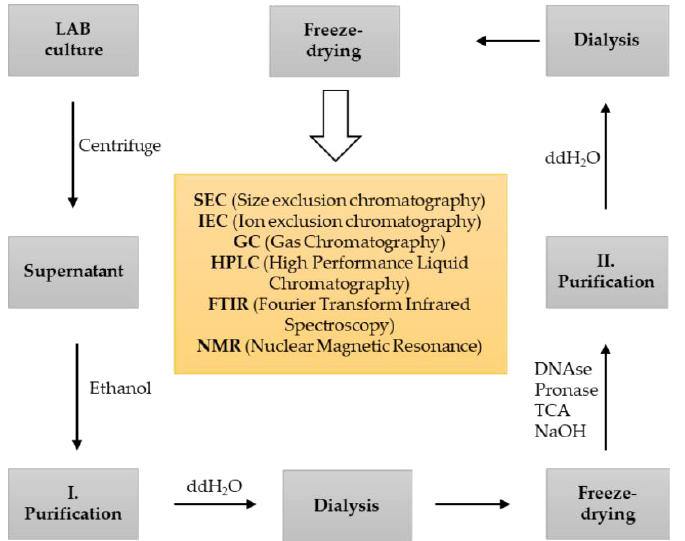
Figure 2. Flow chart for isolation, purification steps (I – first purification, II – second purification), and characterization of EPS.